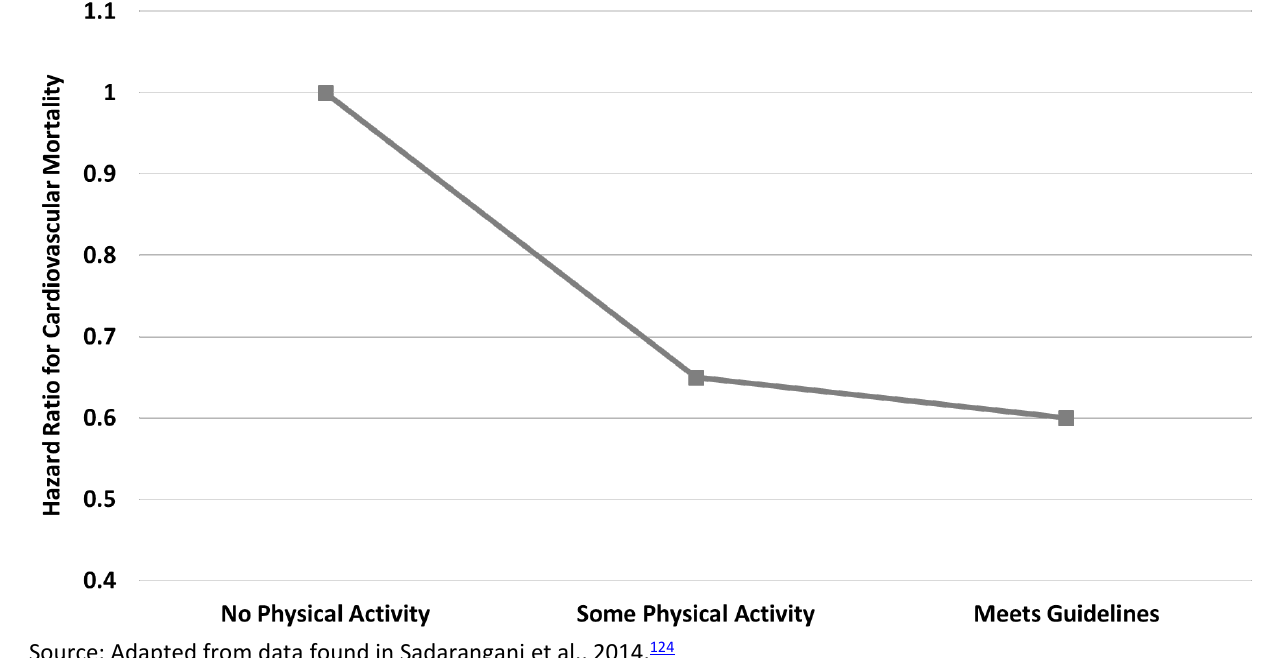
Figure F10-7. Dose-Response Relationship Between Physical Activity and Cardiovascular Disease Mortality in Individuals with Type 2